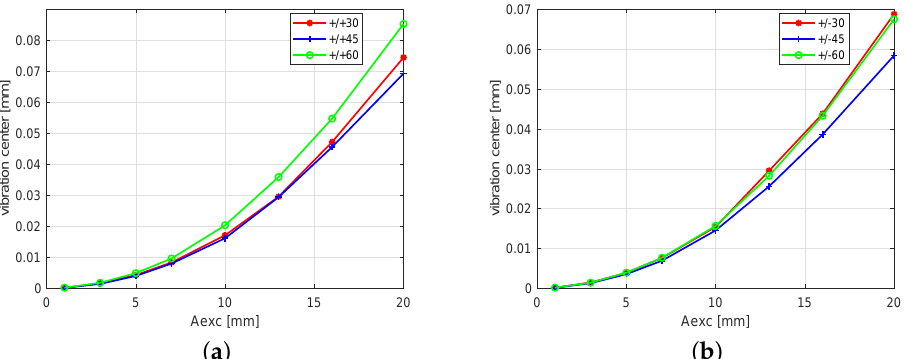
Figure 6. Movement of the vibration center depending on the fiber set and the excitation amplitude for symmetric ( a ), and antisymmetric configurations ( b ),